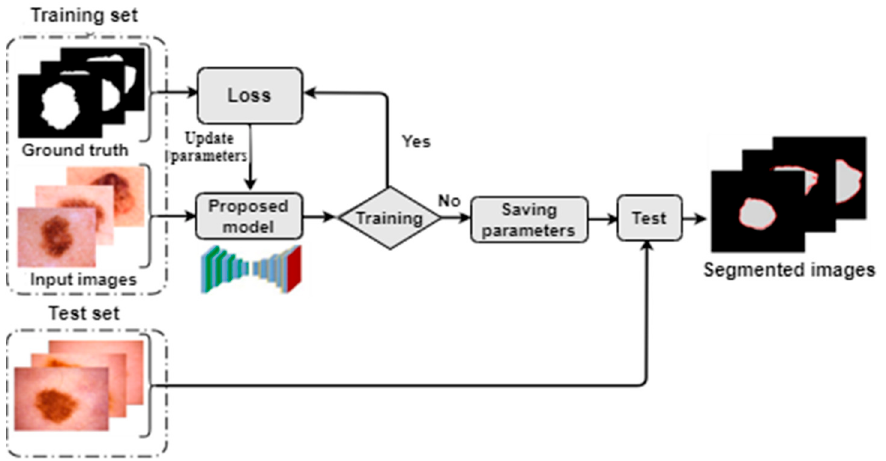
Figure 3. Proposed system flowchart.